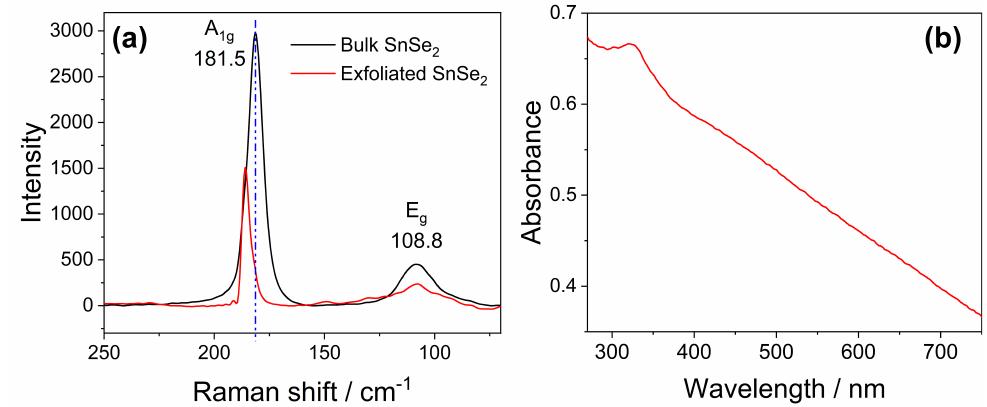
Figure 3. ( a ) Raman spectra of bulk SnSe 2 (black line) and exfoliated SnSe 2 nanoflakes (red line) ( λ ex = 532 nm). The blue dot line is a guide for eyes. ( b ) UV-Vis absorption spectrum SnSe 2 flakes dispersed in ethanol (0.83 g L − 1